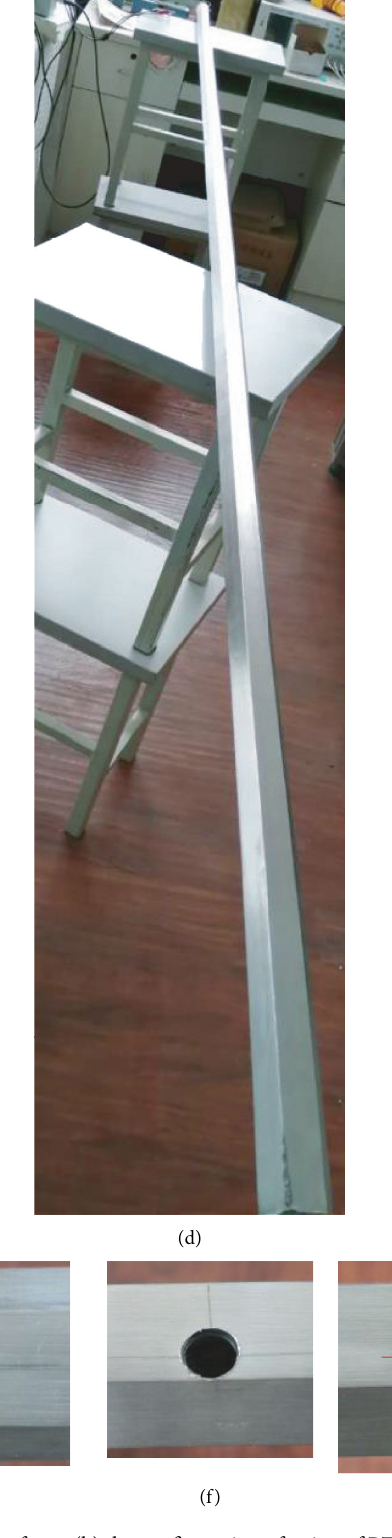
Figure 16: Experimental setups: (a) experimental platform; (b) the configuration of a ring of PZTs with the size of 25mm × 5 mm × 0.5mm; (c) a ring of PZTs with the size of 30mm × 5mm × 0.5mm; (d) experimental specimen of hexagonal pipes; (e) circular hole damage located in the center of a surface plane; (f) circular hole damage near the edge of a surface plane; and (g) slot damage located at the edge with its